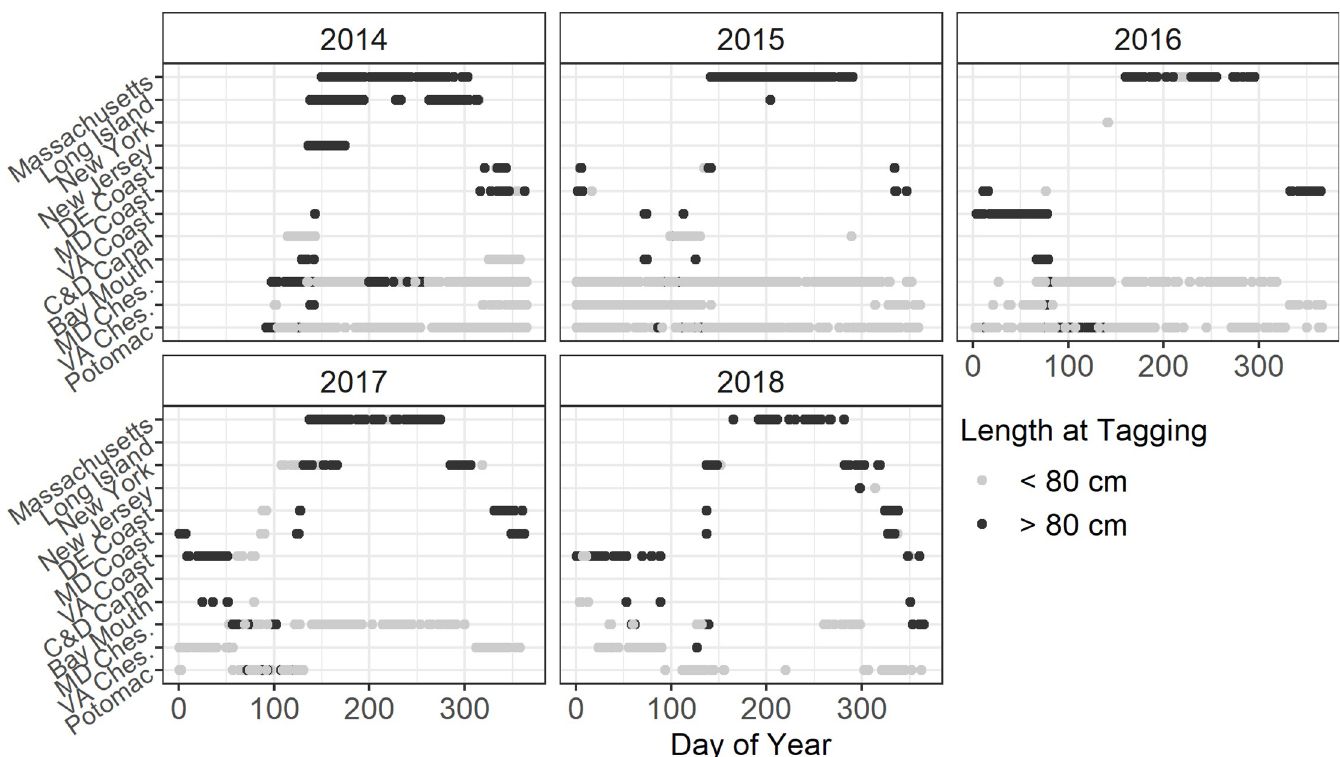
Fig 6. Seasonal migrations by study striped bass in the Chesapeake and NW Atlantic shelf waters. Symbols indicate daily detections for small ( � 80 cm TL) and large ( > 80 cm TL) size classes. Locations are arranged along the y-axis according to latitude.